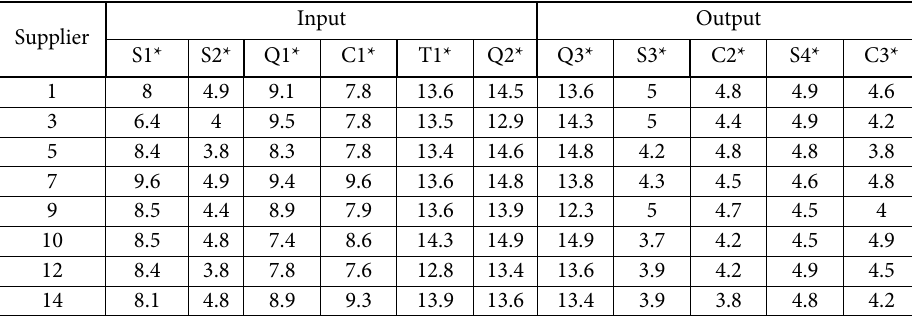
Table 25. Original inputs and outputs data for